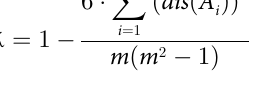
ffiffiffiffiffiffiffiffiffiffiffiffiffiffiffiffi p ð m (cid:0) 1 Þ